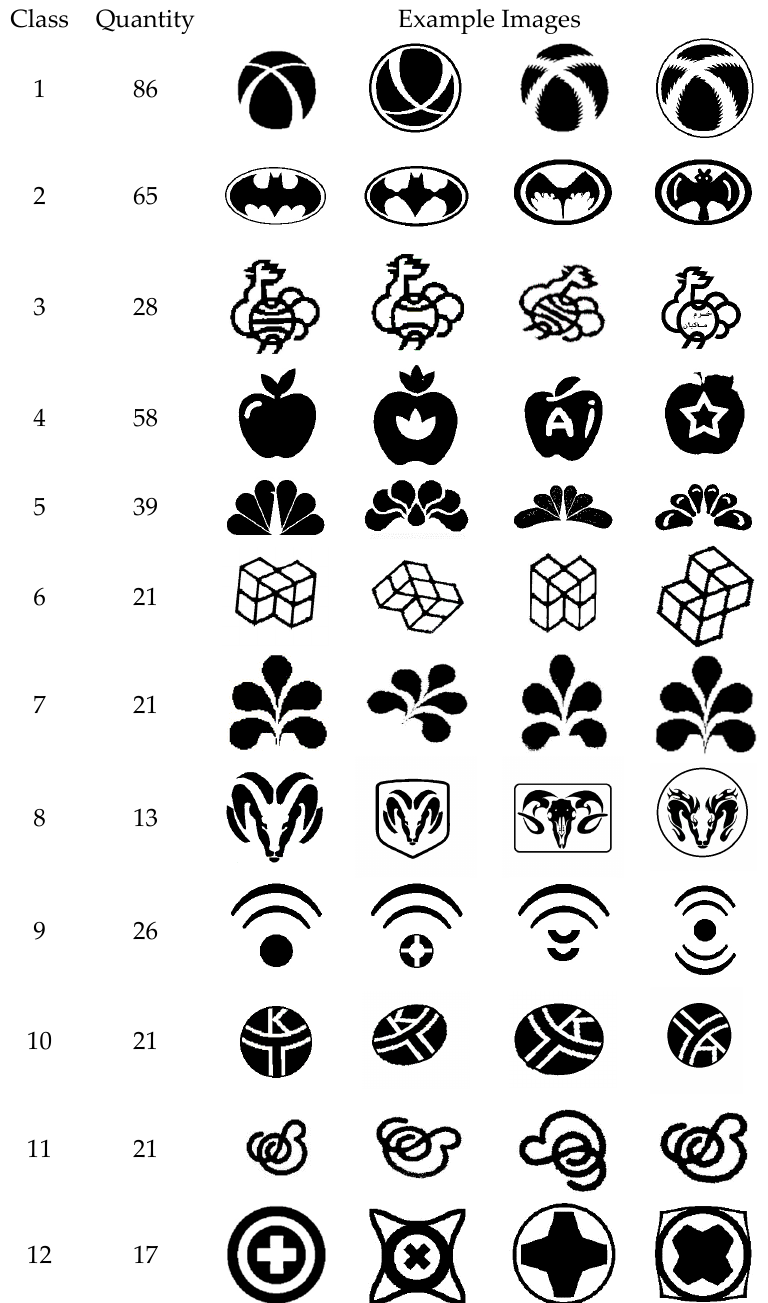
Figure 8. Trademark database in this study .